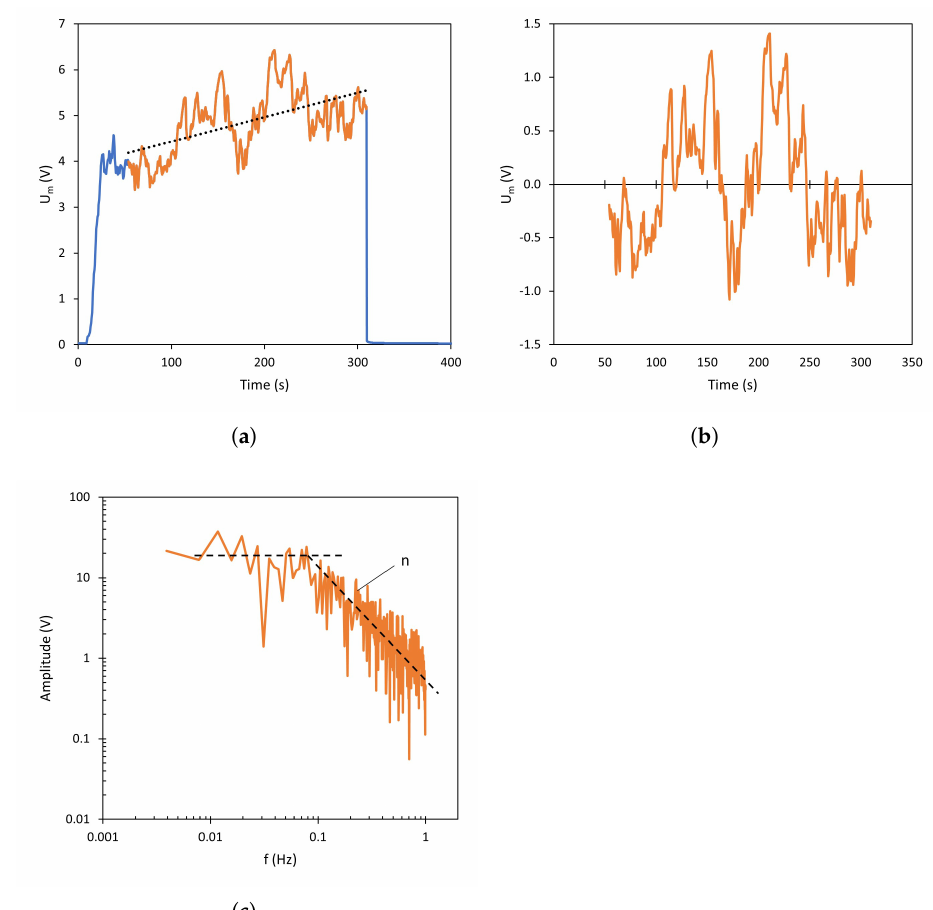
Figure 2. Treatment and standardization of chronopotentiograms for the FFT analysis. ( a ) Original chronopotentiogram before treatment, ( b ) after treatment, and ( c ) resulting spectrum obtained after the signal treatment via Fast Fourier Transform. Dashed lines represent the average trend of the